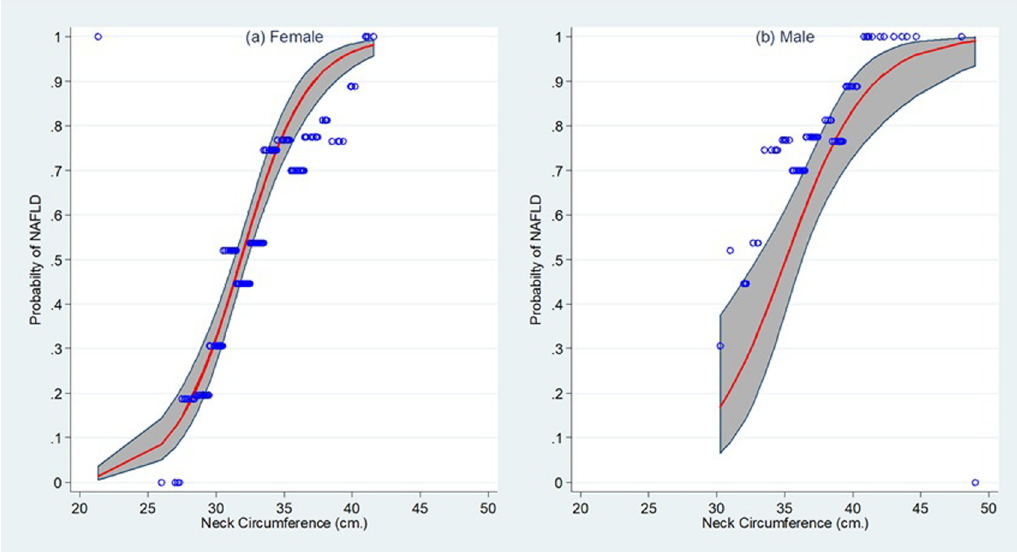
Fig 2. Distribution of the observed and predicted probabilities of having non-alcoholic fatty liver disease (NAFLD) across neck circumference level among for (a) female and (b) male participants. Thick line represents the expected probability, hollow circle represents the observed probability, shade represents the 95% confidence interval of the expected